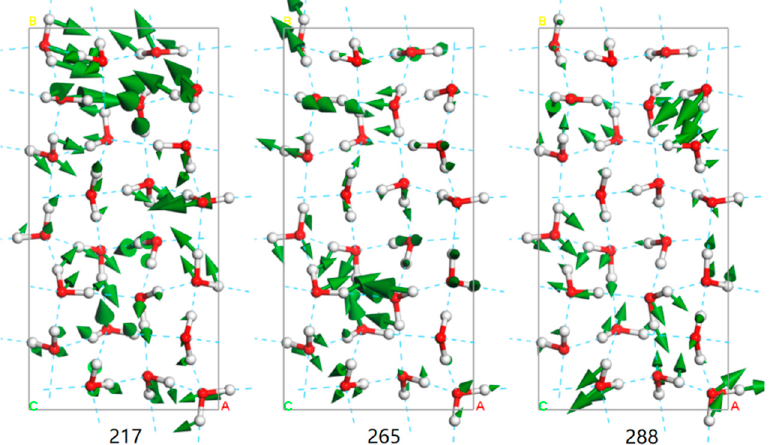
Figure 3. Three vibrational modes at 217 cm − 1 , 265 cm − 1, and 288 cm − 1 of ice III in the translational band. The green arrow indicates the vibrational direction and its size is proportional to the amplitude. The blue dotted lines represent the HBs.